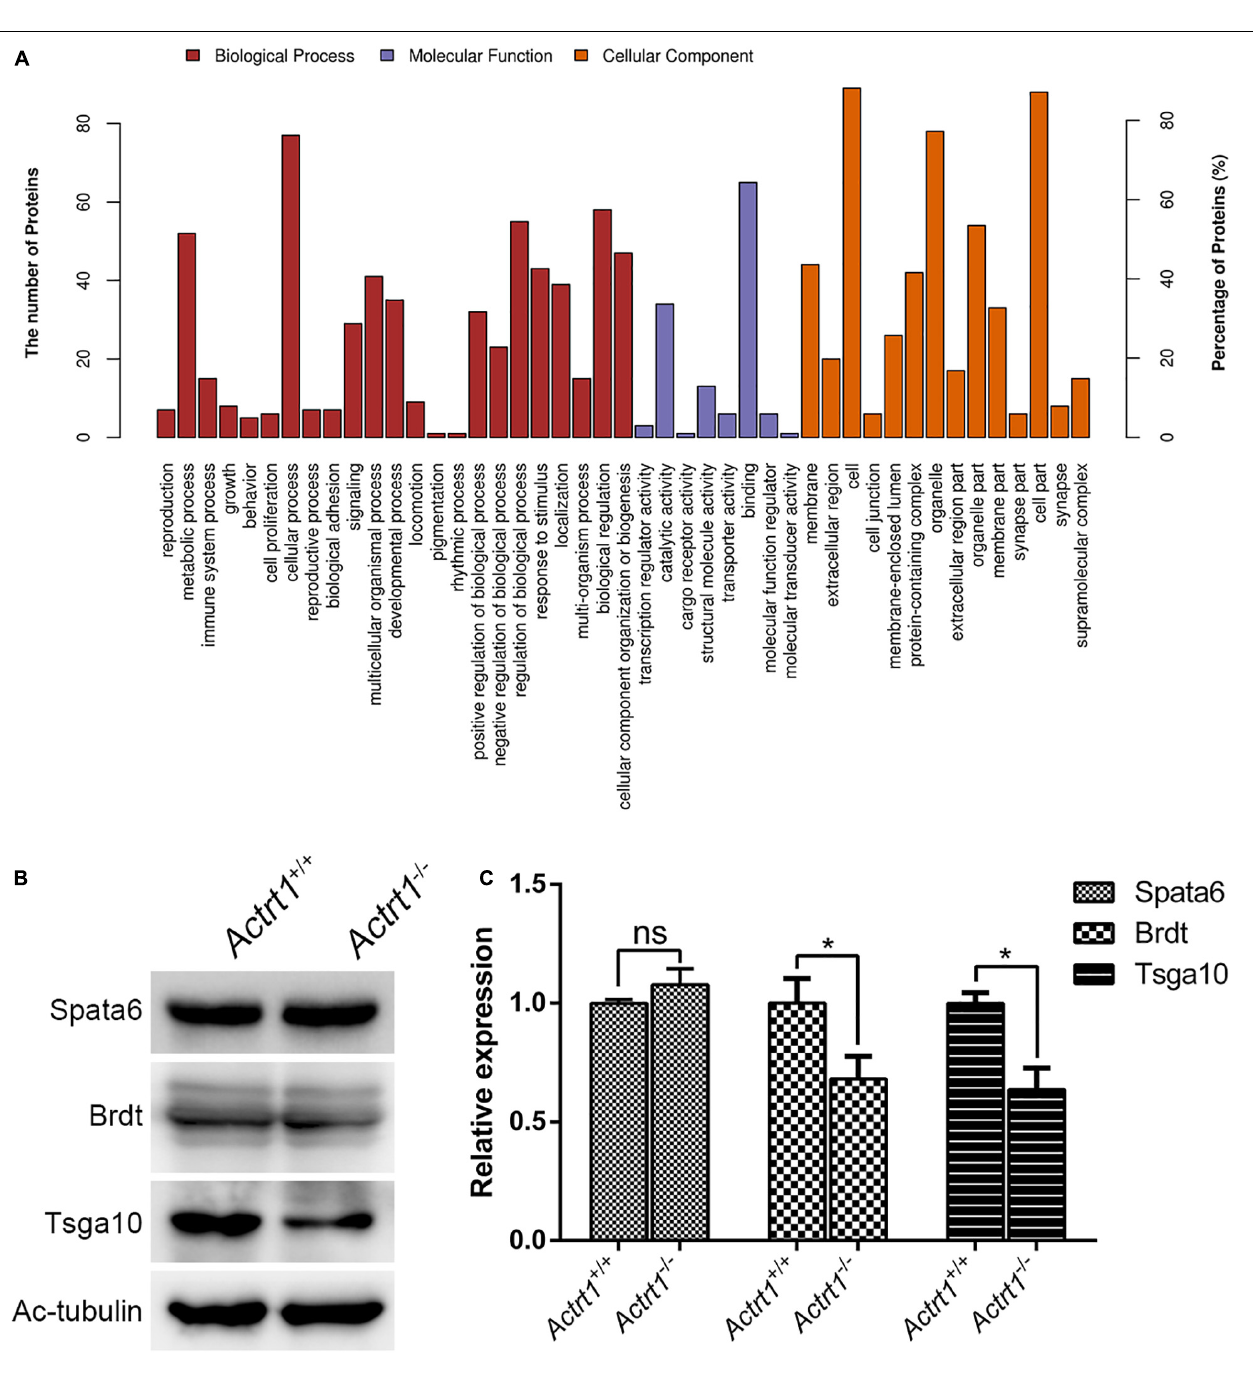
FIGURE 5 | Label-free quantitative proteomics analysis of the testes from Actrt1-null mice. (A) Gene ontology analysis of the changed proteins from the testis of Actrt1-knockout mice. (B) Western blot analysis the expression of the proteins associated with acephalic spermatozoa syndrome. (C) The quantitative results from three independent experiments as described in (B) . * P <